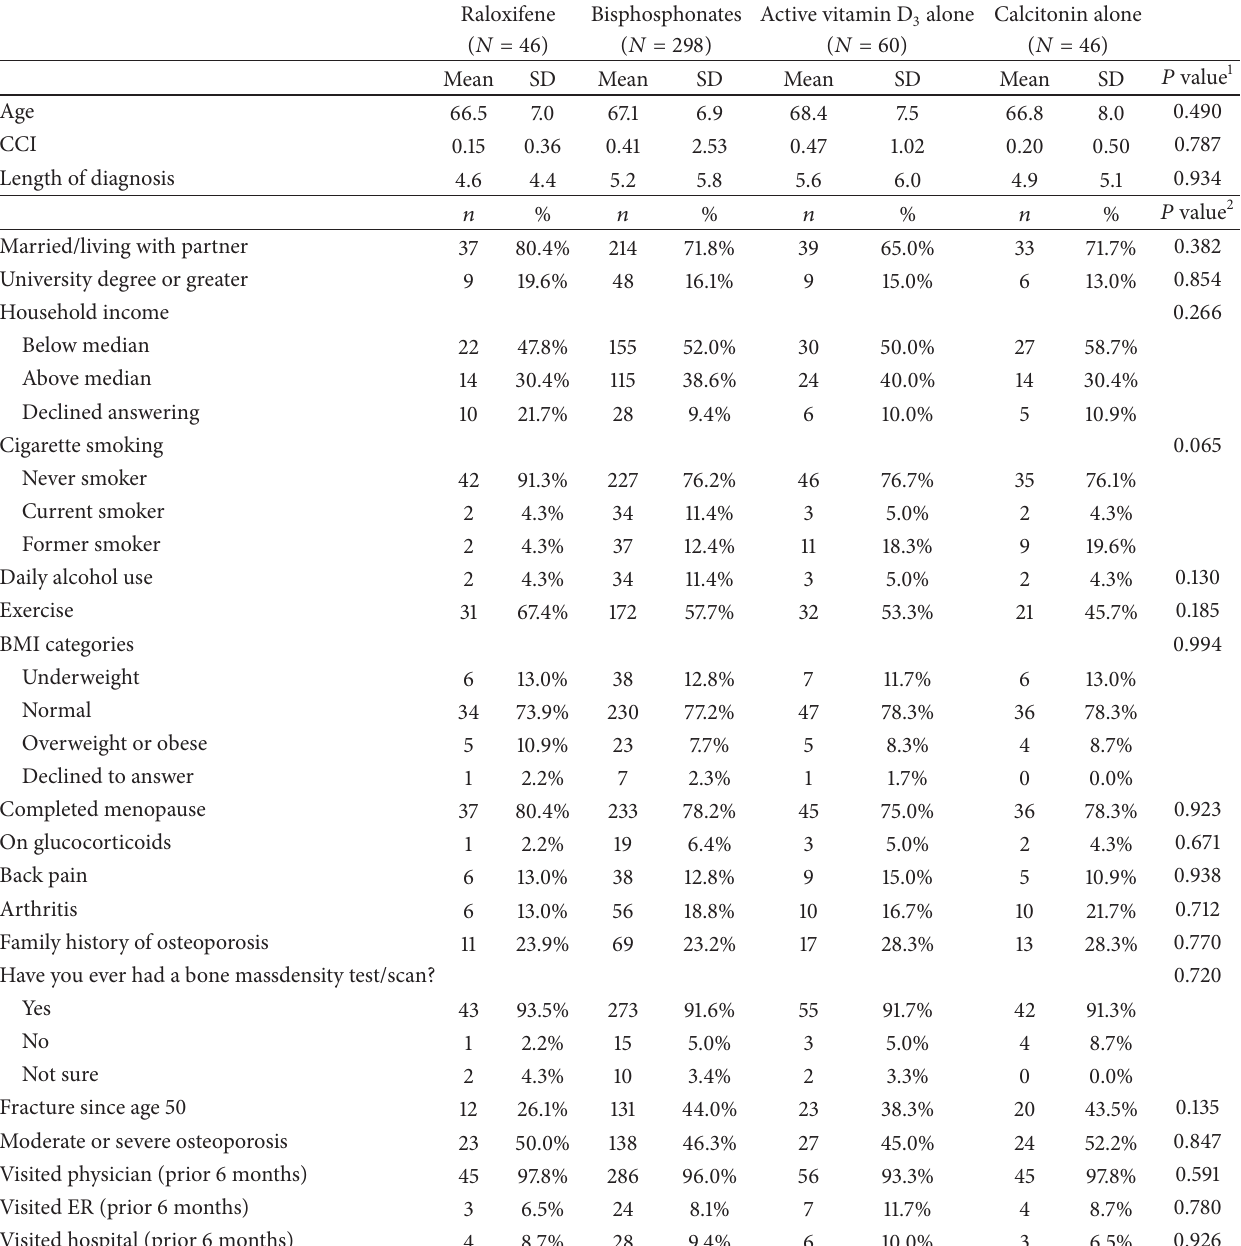
Table 3: Patient characteristics according to type of osteoporosis treatment ( 𝑁 = 450